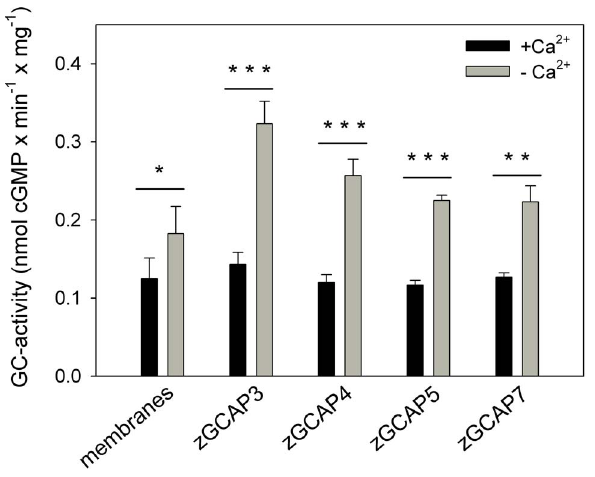
Figure 5. GC activities in adult zebrafish retinae. Membranes from adult zebrafish retinae were incubated with 10 m M recombinant myristoylated zGCAPs as indicated. GC activities were measured in the presence of 100 m M Ca 2 + ( + Ca 2 + ) or in the absence of Ca 2 + (2 mM EGTA, -Ca 2 + ). Data are mean 6 s.d. of three replicates. Differences of activities in the presence of zGCAPs were highly significant: zGCAP3 ( t =9.53, *** P # 0.001); zGCAP4 ( t =10.26, *** P # 0.001); zGCAP5 ( t =17.9, *** P # 0.001); zGCAP7 ( t = 7.76, ** P # 0.01); membranes ( t = 2.27, * P , 0.05).